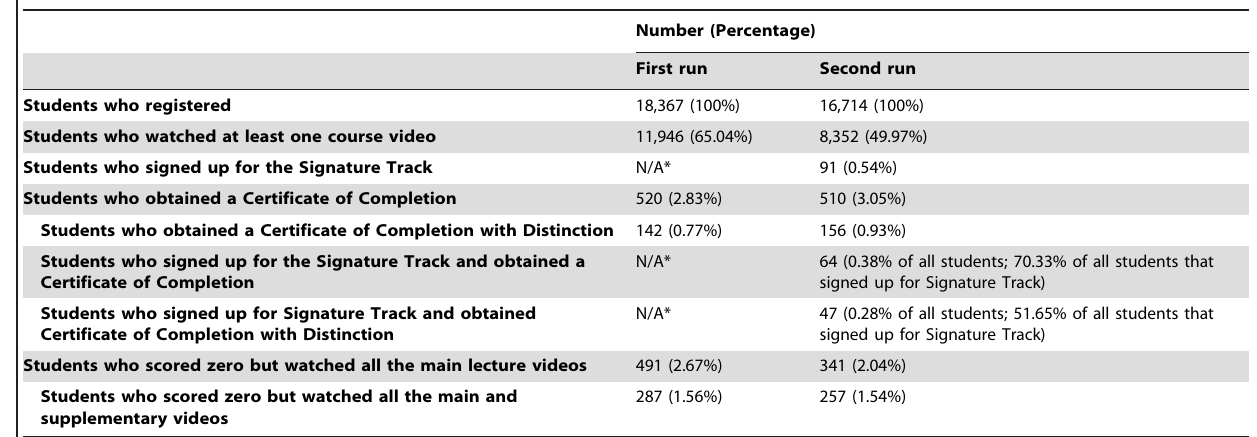
Table 2. Overall statistics of the